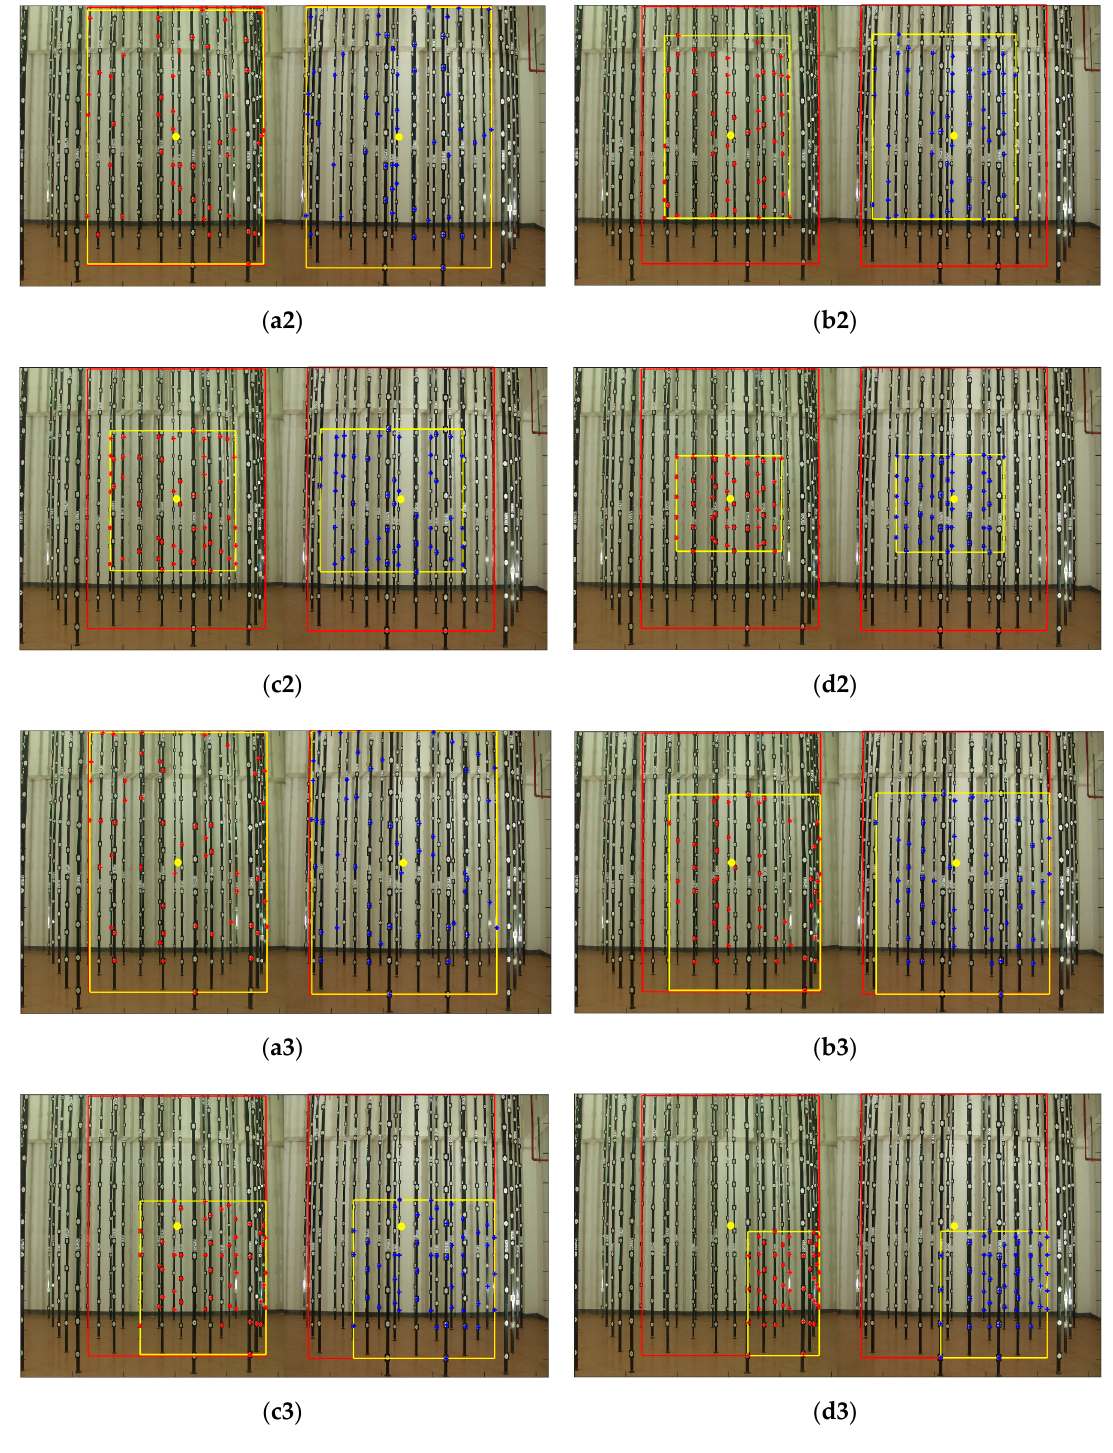
Figure 3. Matching points with different numbers and different distributed regions. There are 227 pairs in ( a1 ), 160 pairs in ( b1 ), 90 pairs in ( c1 ), and 20 pairs in ( d1 ) in the same distributed regions. There are 50 pairs of matching points gathered toward the center point of overlapping regions in ( a2 – d2 ), and toward the lower-right corner of the overlapping regions in ( a3 – d3 ). The red rectangle indicates the overlapping region of stereo pairs, the yellow rectangle indicates the region where matching points are located, and the yellow dot indicates the position where the center point of the overlapping region is located.